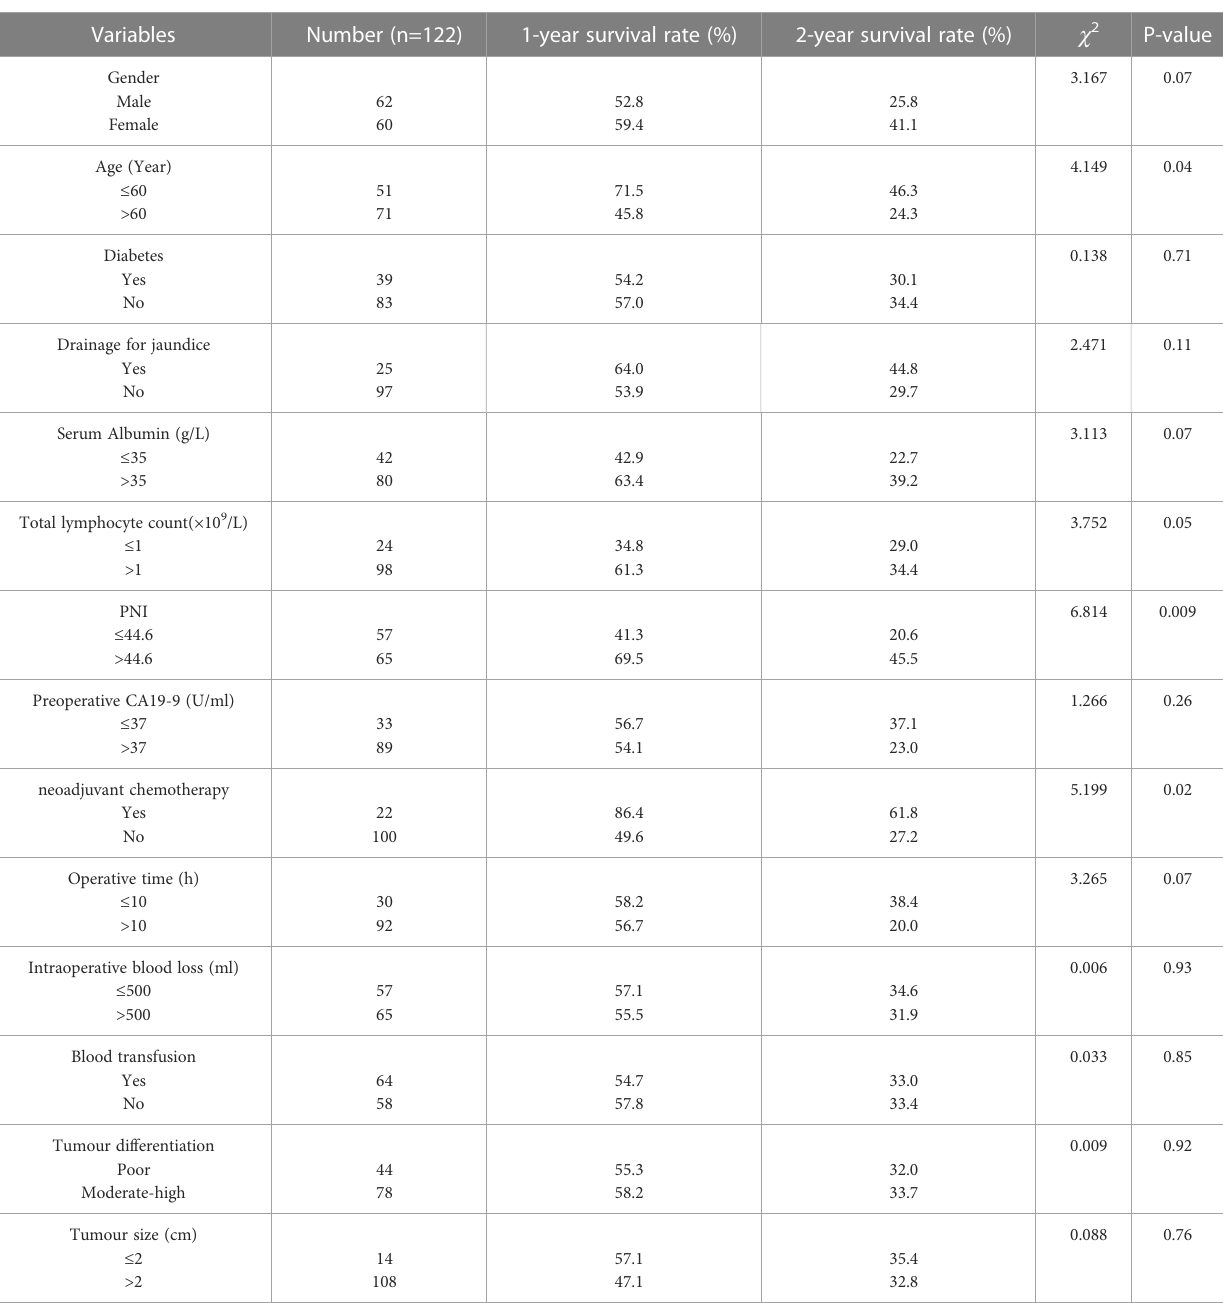
TABLE 4 Univariate analysis of long-term survival in patients with